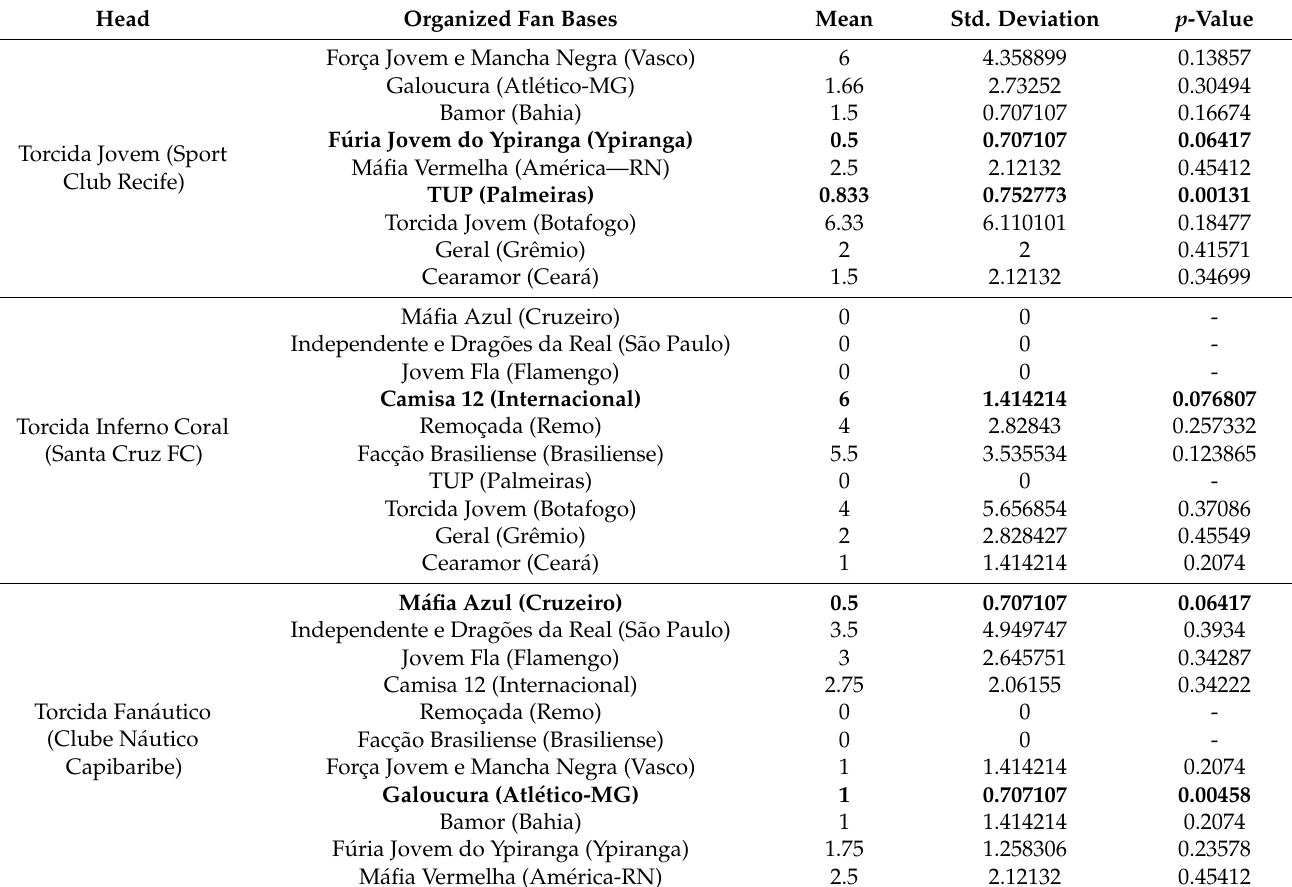
Table 4. The hypotheses test based on occurrences declared enemies and